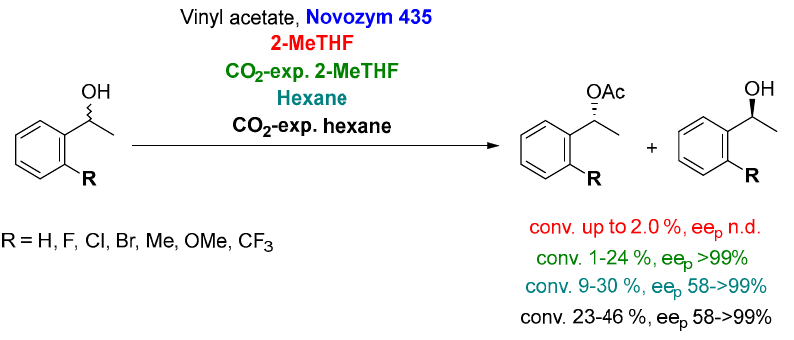
Figure 26. Lipase-catalyzed resolution of several ortho -substituted 1-phenylethanols in different sol- vents.